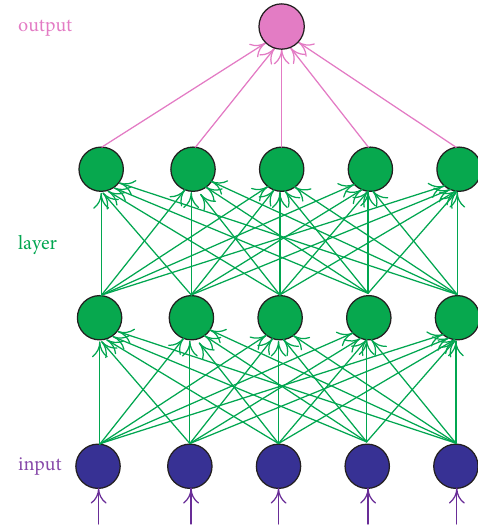
Figure 2: Traditional neural